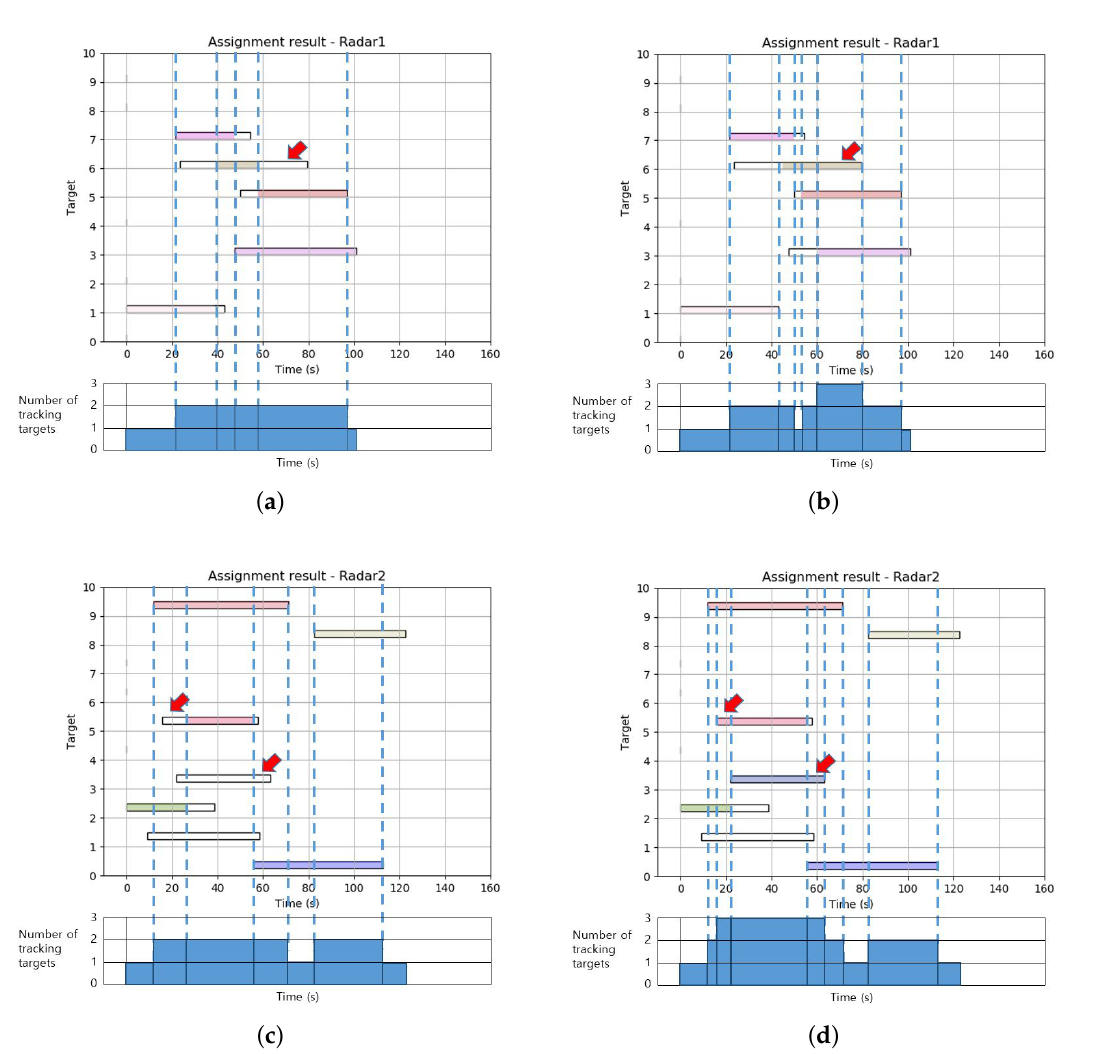
Figure 7. Optimal scheduling assignment result of each radar site according to the change of simultaneous tracking capability. ( a ) Assignment result of first radar when n capa = 2. ( b ) Assignment result of first radar when n capa = 3. ( c ) Assignment result of second radar when n capa = 2. ( d ) Assignment result of second radar when n capa =